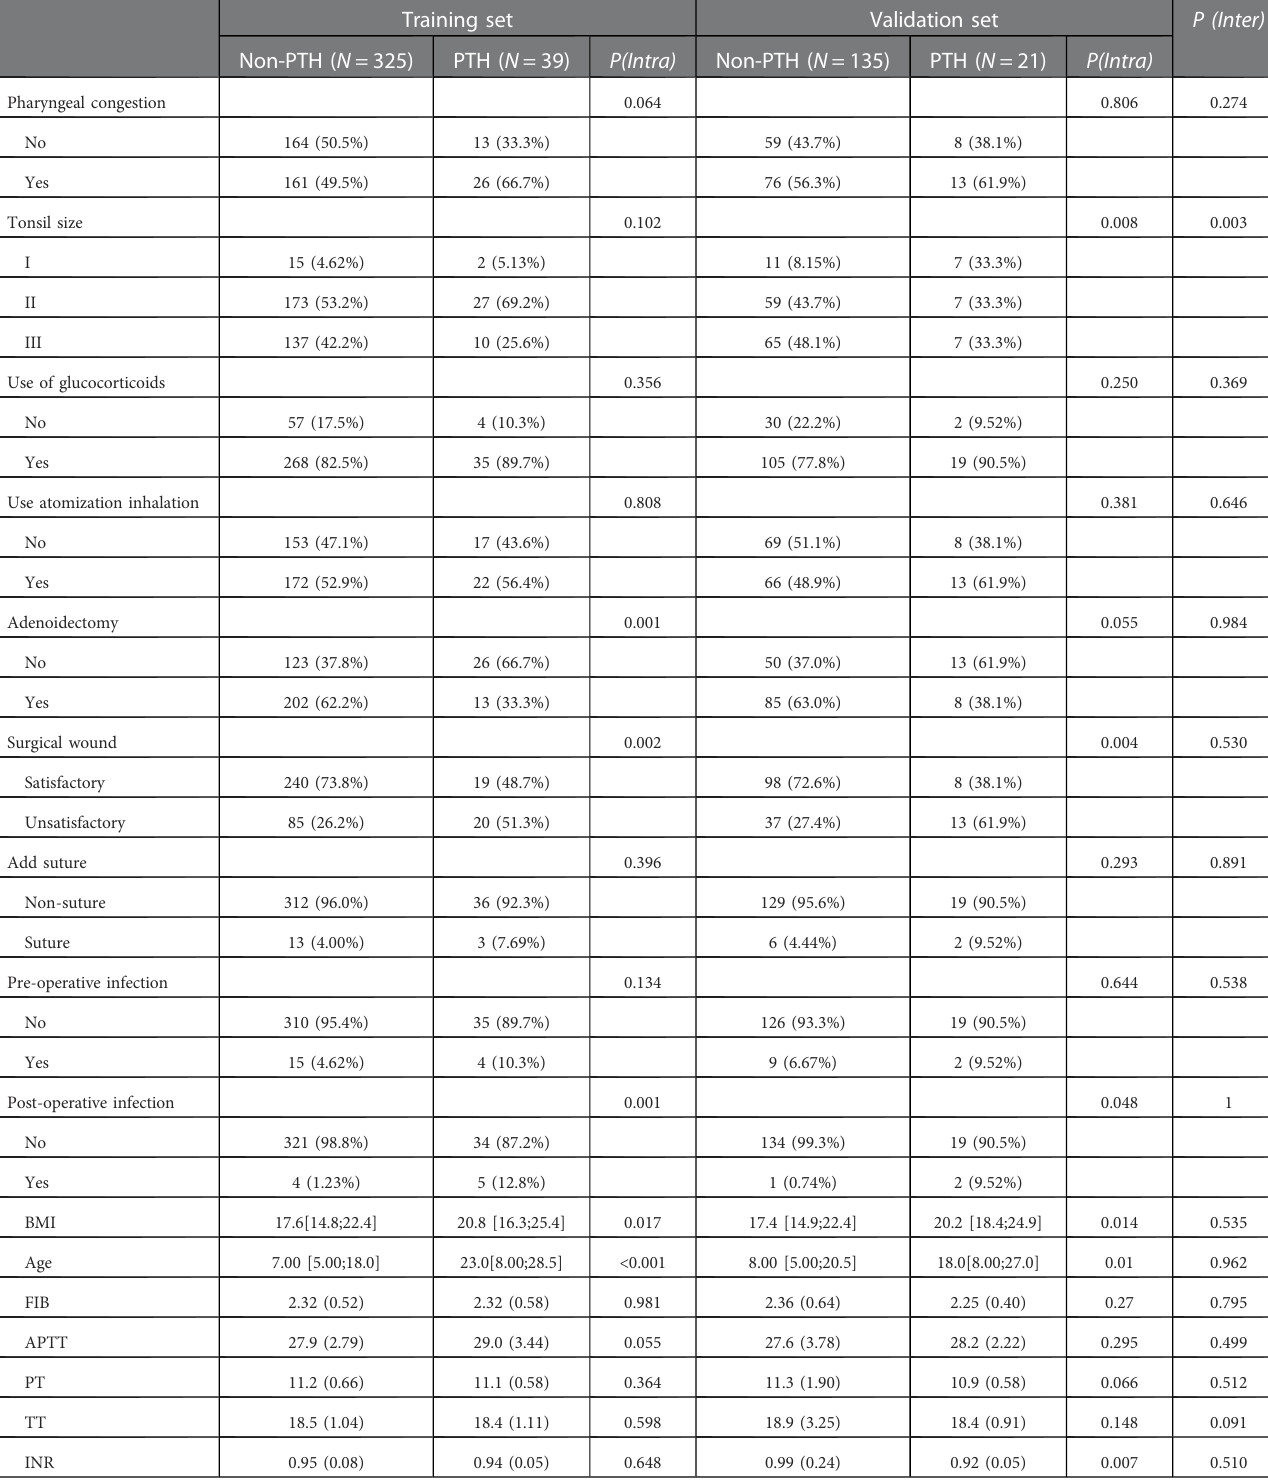
the estimated value, where red represents the higher value and blue represents the lower value. The horizontal coordinate is the SHAP value. The larger shape indicated that the feature had a